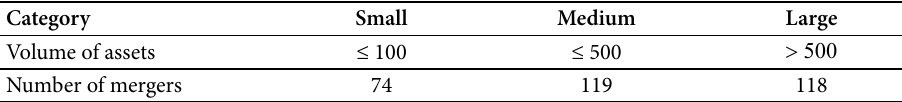
Table 4. Categories of companies based on the volume of assets (mCZK)